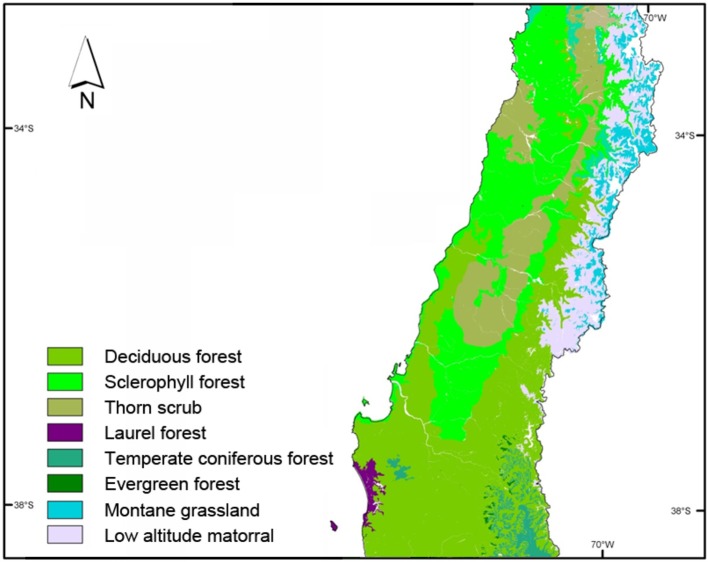
Natural vegetation in central-southern Chile. Source: Luebert and Pliscoff (2006).